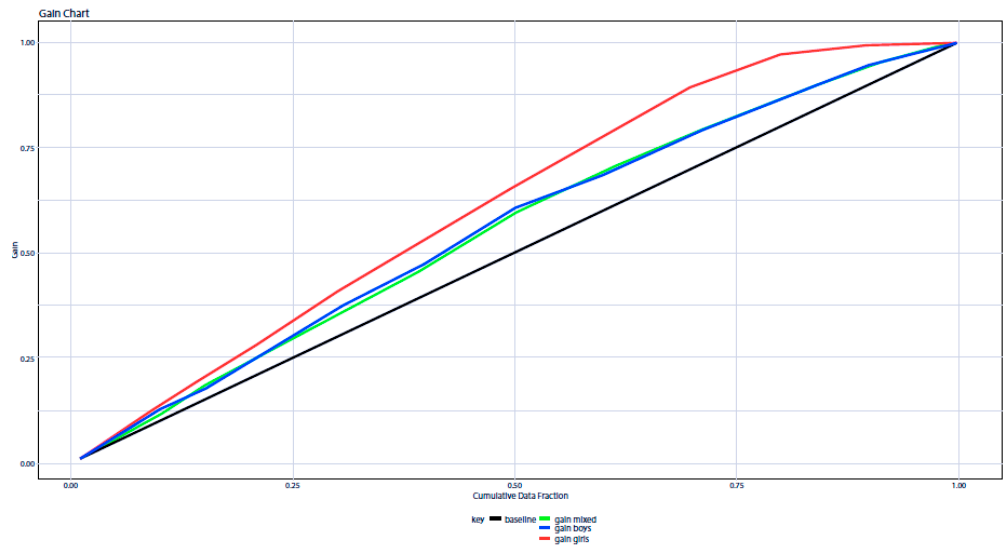
Figure 8. Gain chart comparison of the mixed student sample and the gender-differentiated